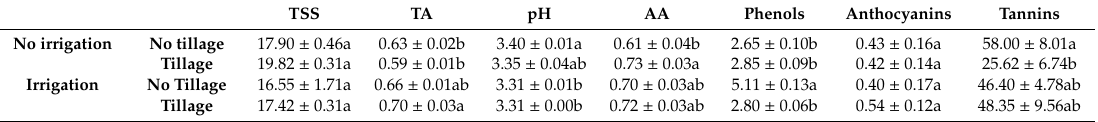
Table 3. E ff ects of irrigation and tillage on Xynisteri cultivar on grape total soluble solids (TSS: o Brix), titratable acidity (TA: % tartaric acid), pH, ascorbic acid (AA: mg 100 mL − 1 grape juice), total phenols (gallic acid equivalent: GAE 100 g − 1 Fw), anthocyanins (mg cyn-3-glu 100 g − 1 Fw) and tannins (mg 100 mL − 1 grape